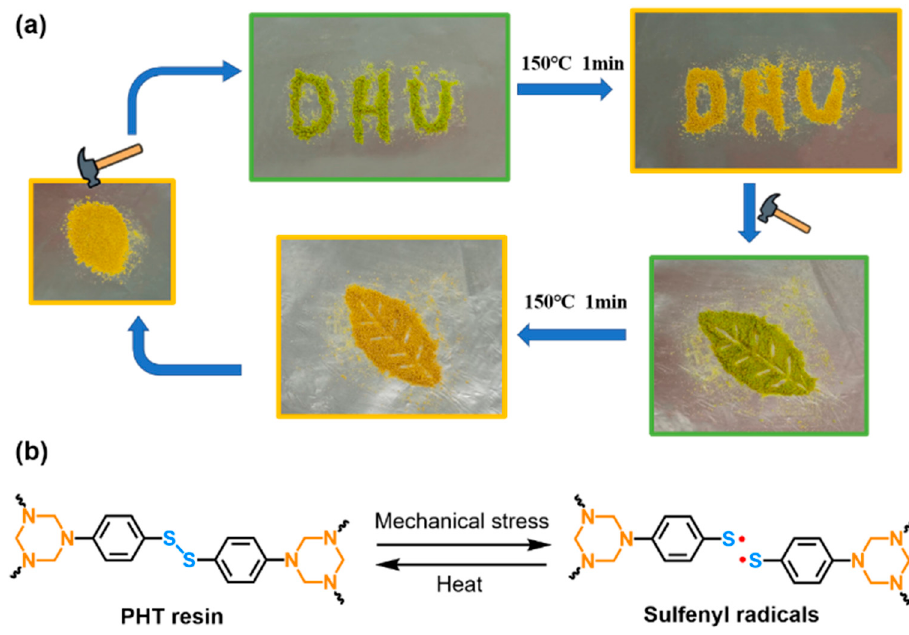
Figure 7. ( a ) Reversible mechanochromic behaviors of the PHT. ( b ) A schematic illustration of the generation and coupling of sulfenyl radicals in the PHT networks.